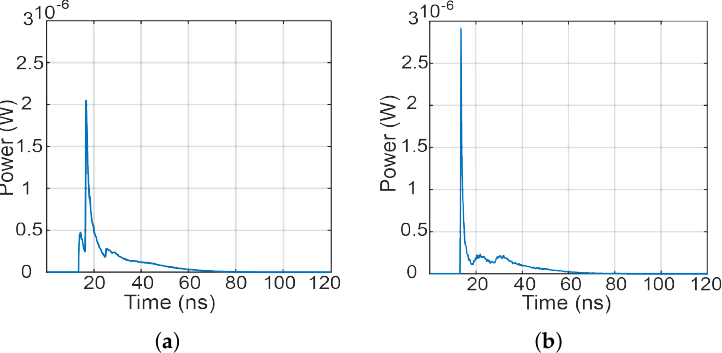
Figure 3. Impulse response of the link with MP acting as a Rx when using: ( a ) front camera; and ( b ) rear